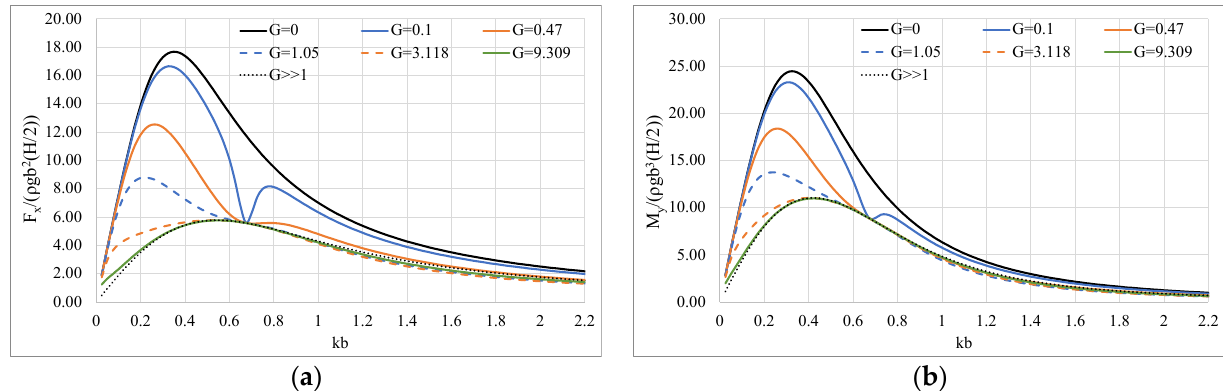
Figure 5. Effect of the porous coefficient 𝐺 on the horizontal exciting wave loads on a porous bottom-mounted cylindrical